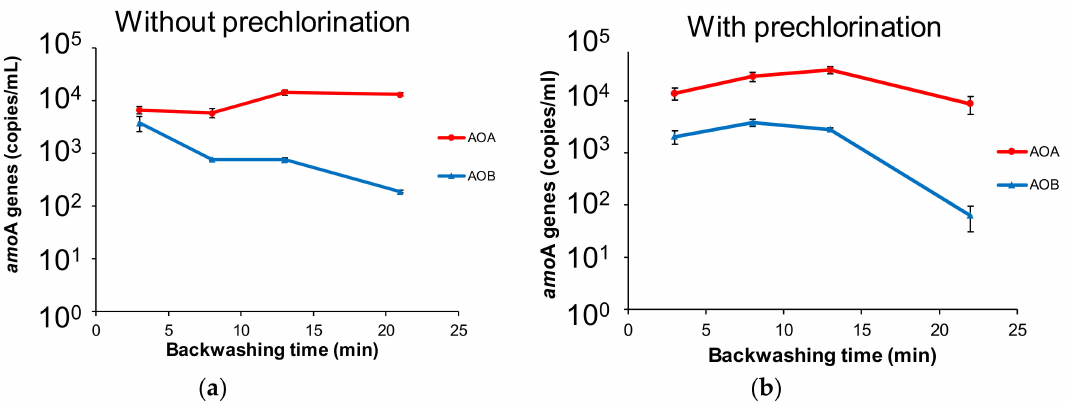
Figure 4. The abundances of the amo A genes of AOA ( • ) and AOB ( (cid:78) ) in the backwashing water during the backwashing program. The water samples were collected without prechlorination ( a ) and with prechlorination ( b